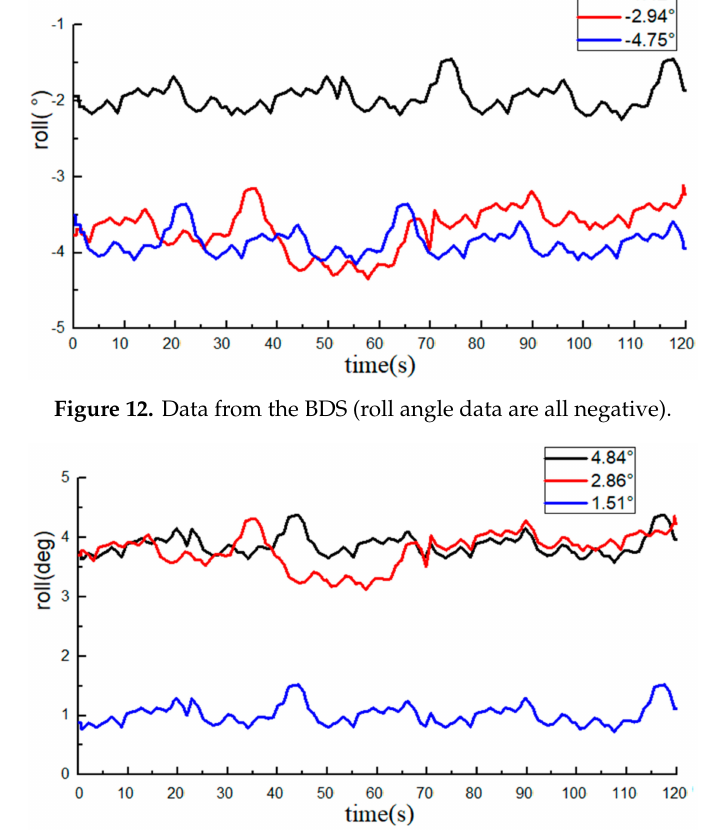
Figure 13. Data from the BDS (roll angle data are all